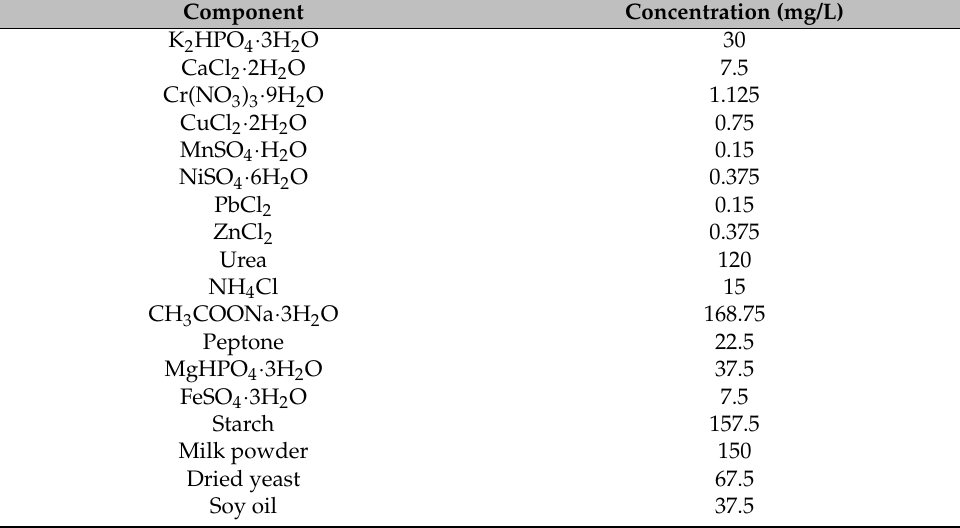
Table 1. Recipe of synthetic